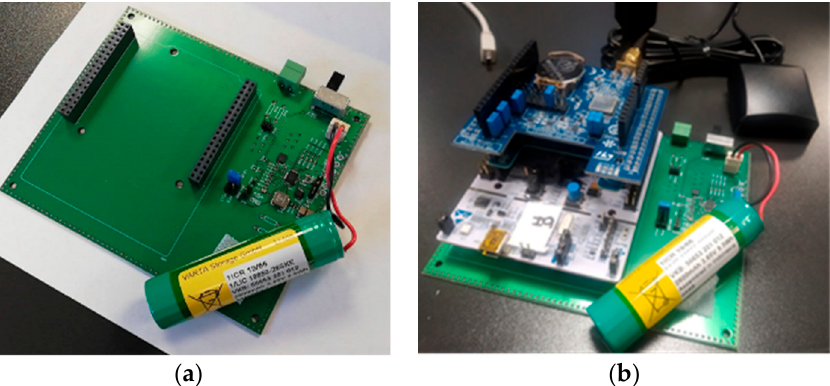
Figure 11. ( a ) Prototyping board and ( b ) a node mounted on the board ready for measurements.